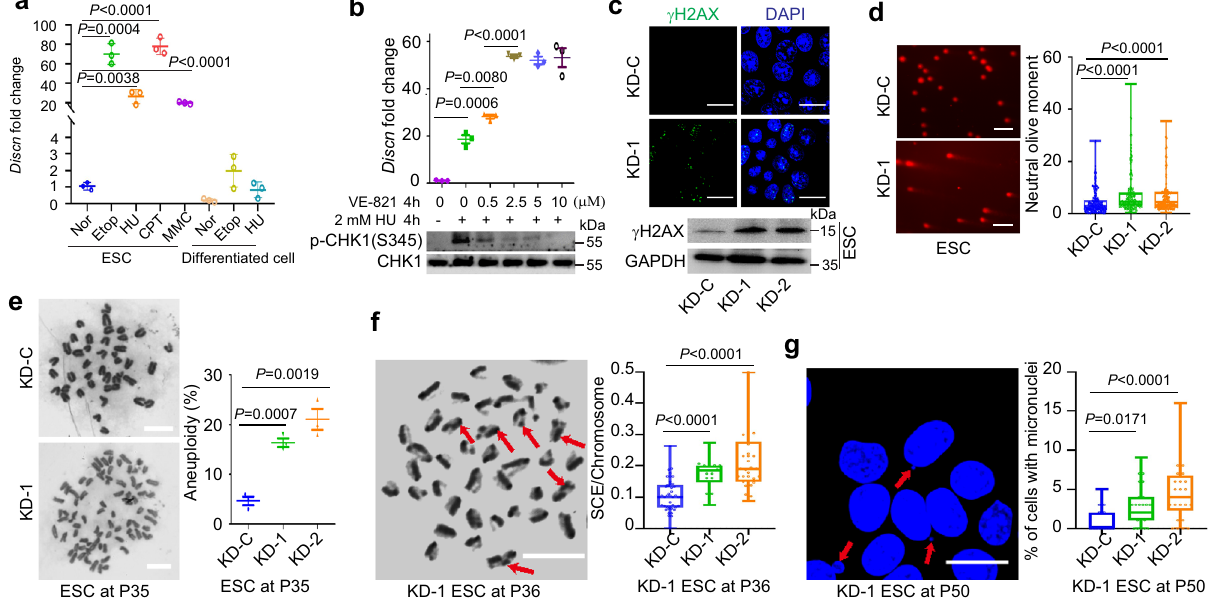
Fig. 1 Discn safeguards genomic stability of mouse ESCs. a Mouse ESCs and their differentiated isogenic cells were cultured in normal condition (Nor) or treated with 2 mM hydroxyurea (HU), 10 μ M etoposide (Etop), 1 μ M camptothecin (CPT), or 8 μ g/mL mitomycin C (MMC) for 4 h. The relative expression level of Discn was determined by quantitative RT-PCR. The amount in ESCs under normal condition was set as 1.0. n = 3 biologically independent samples. Data were presented as mean ± SEM, two-tailed unpaired t test. b Quantitative RT-PCR showed Discn expression was increased by HU-induced replication stress. Blockage of ATR signaling by inhibitor VE-821 further stimulated the expression of Discn in a dose-dependent manner. The Discn amount in ESCs under normal condition was set as 1.0. Upper panel showed the Discn expression fold changes and lower panel was the validation of ATR inhibition by VE- 821. n = 3 biologically independent samples, two-tailed unpaired t test. Data were presented as mean ± SEM. c Compared to control (KD-C), knockdown of Discn by two independent shRNAs (KD-1 and KD-2, respectively) increased DNA double-strand breaks (DSBs) as monitored by the increased level of γ H2AX. Upper panel showed the representative immunostaining images. Lower panel showed the immunoblotting result. Three independent experiments were repeated with similar results. Scale bar, 20 μ m. d Neutral comet assay validated the increased DNA DSBs in Discn KD cells. Left panel, the representative images. Right panel, the quanti fi cation of comet tail length. At least 100 tails were analyzed in each group in three independent replications. Scale bar, 400 μ m. e Discn KD ESCs had higher rate of aneuploidy. Representative image at passage 35 (P35) (Left panel) and the quanti fi cation (right panel) were obtained from at least 50 metaphase spreads in three independent replications. Data were shown as mean ± SEM, two-tailed Student ’ s t -test. Scale bar, 10 μ m. f Discn KD increased the sister chromatid exchange rates. Left panel showed the representative images of sister chromatid exchange (arrows) in KD ESCs at passage 36. Quanti fi cation was shown on the right. n = 3 biologically independent samples, at least 20 metaphase spreads were analyzed in each group. Scale bar, 10 μ m. g Discn KD increased micronuclei formation. Left panel showed the representative images of micronuclei (arrows). Scale bar, 20 μ m. Right panel showed the percentages of cells with micronuclei. At least 25 visual fi eld containing 1000 cells were analyzed in three replications. d , f , g Data were representative of individual values with box and whiskers plots showing the median, upper and lower quartiles, and minimum and maximum. Two-tailed Student ’ s t